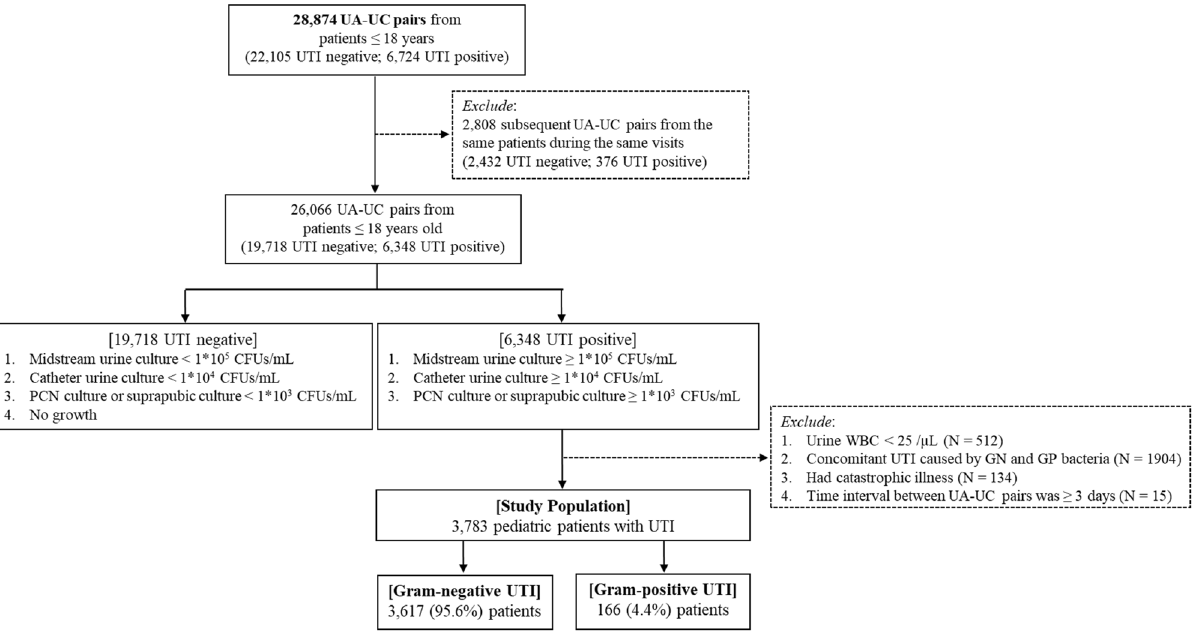
Figure 1. Flowchart of the selection process of the study population (N = 3783